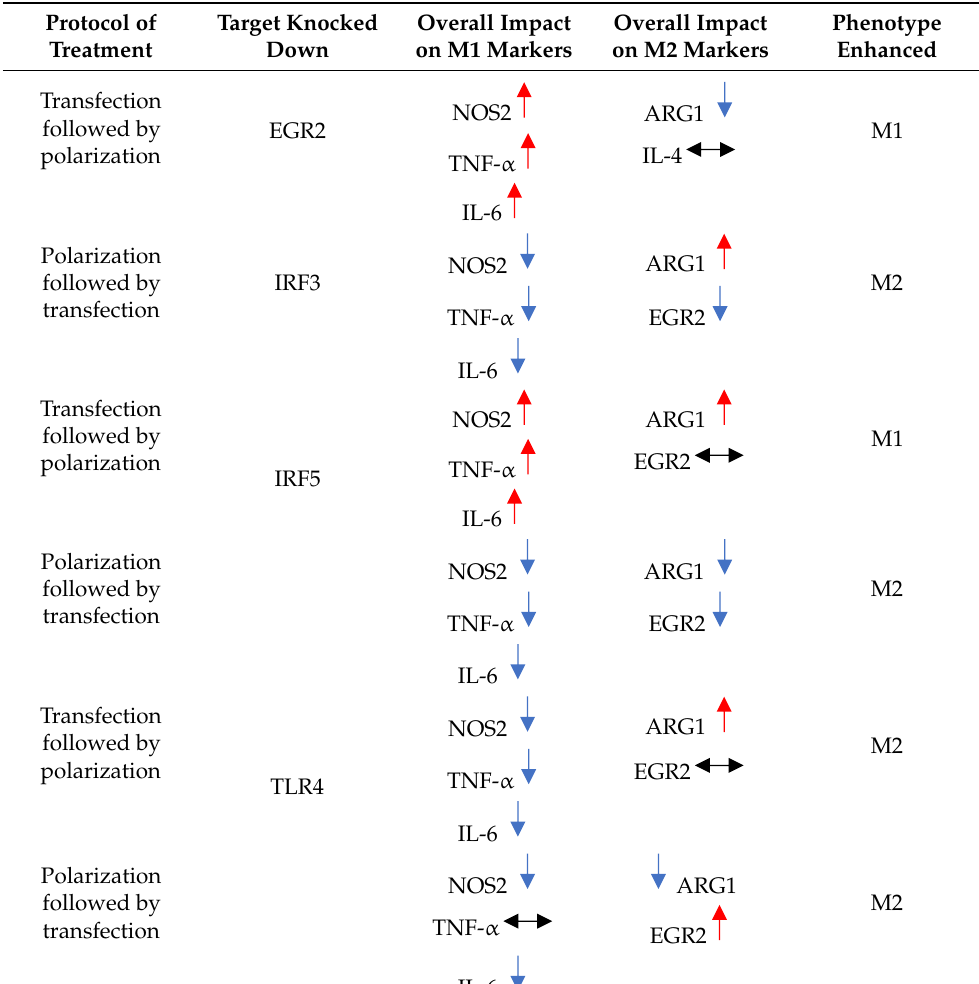
Table 1. A summary of how siRNA-mediated knockdown of selected target genes alters the pheno- type of BMDMs based on the sequence of transfection and polarization.